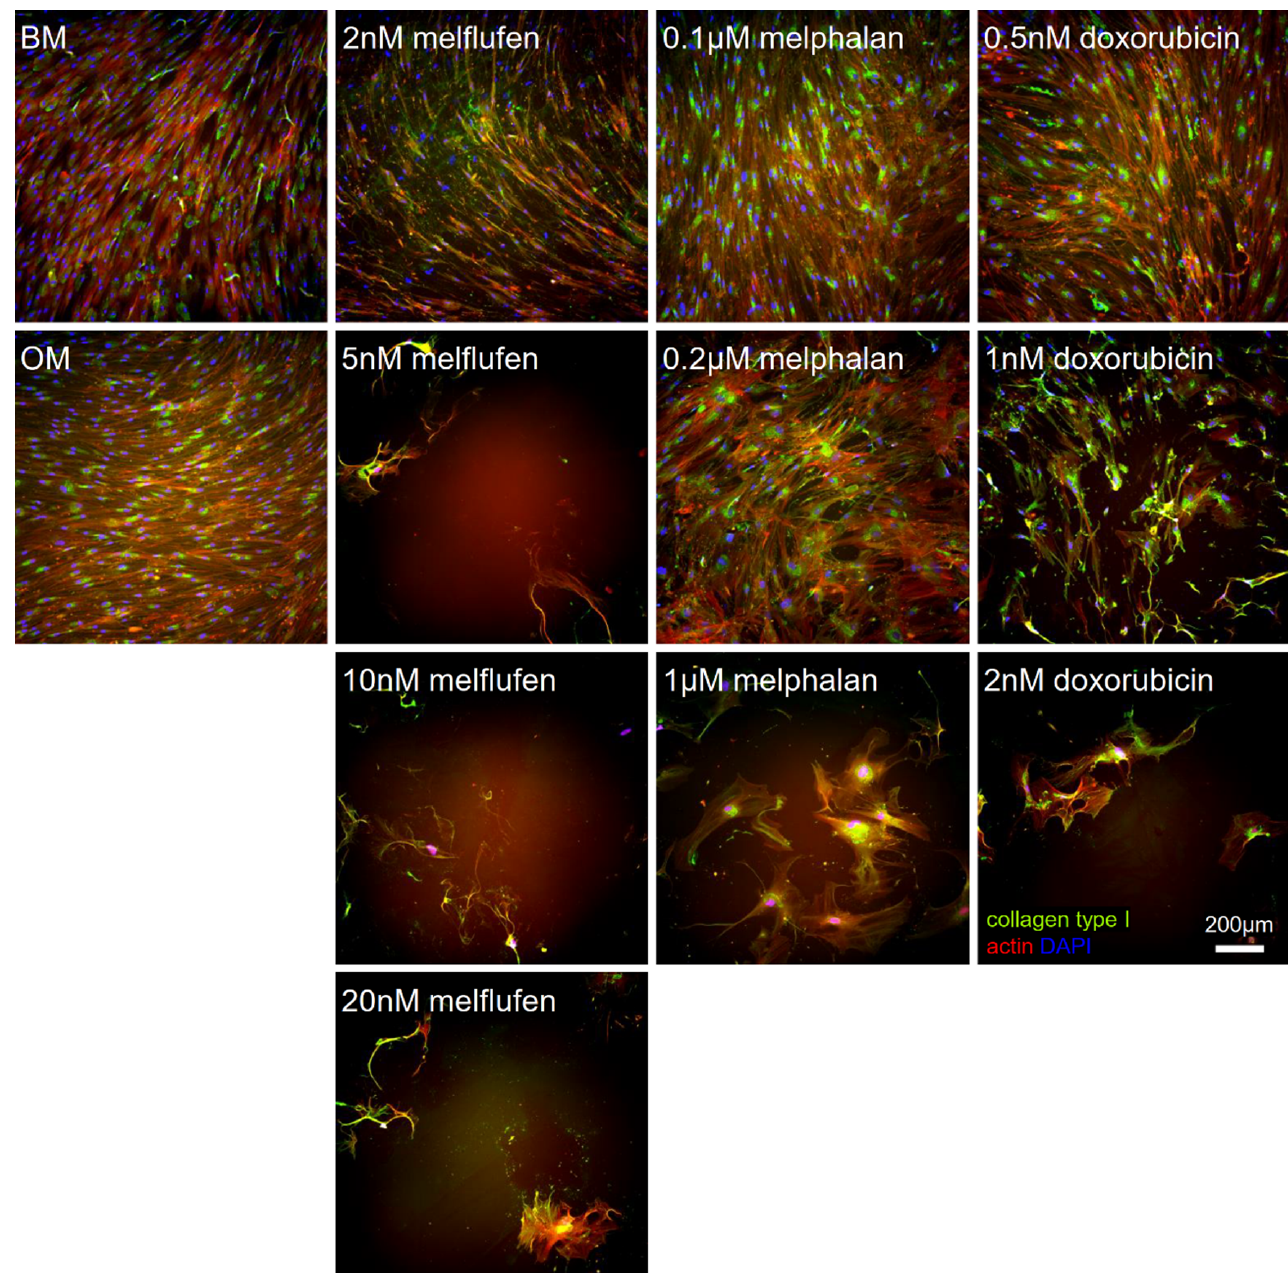
Figure 11. Drug effect on the expression of collagen type I in osteogenically differentiated BMSCs. Immunofluorescent staining for collagen type I (green) in osteogenically differentiated BMSCs at 21 days of culture with melflufen, melphalan, and doxorubicin added at indicated concentrations. Counterstained with phalloidin for actin filaments (red) and DAPI for nuclei (blue). BM, basic medium control; OM, osteogenic medium control without drugs. Scale bar: 200 µm.